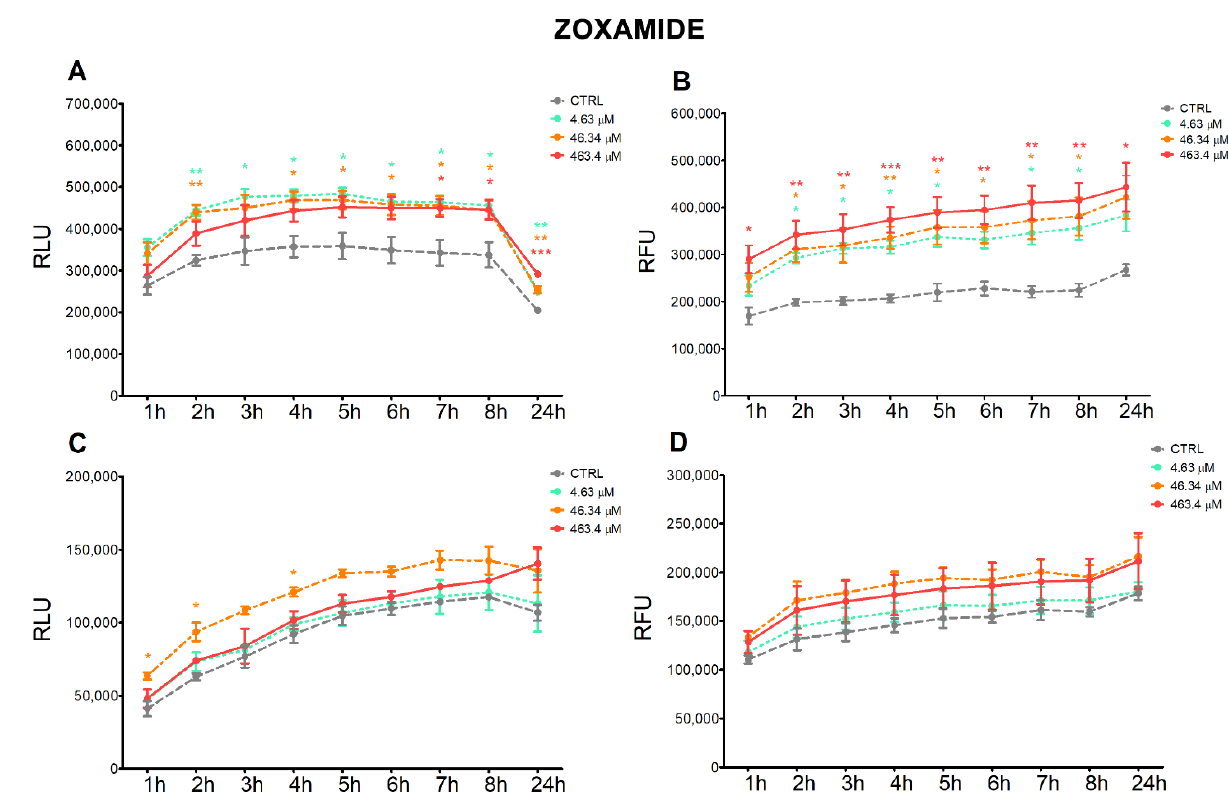
Figure 2. Apoptotic (RLU) and necrotic (RFU) signals evaluated by Annexin V assay in HepG2 ( A , B ) and A549 ( C , D ) cells treated with MZ or solvent control (0.8% DMSO) for 24 h. Values are mean fold-change ± SEM of three independent experiments. Statistical significance is indicated by asterisks: * p < 0.05; ** p < 0.01; *** p < 0.001.